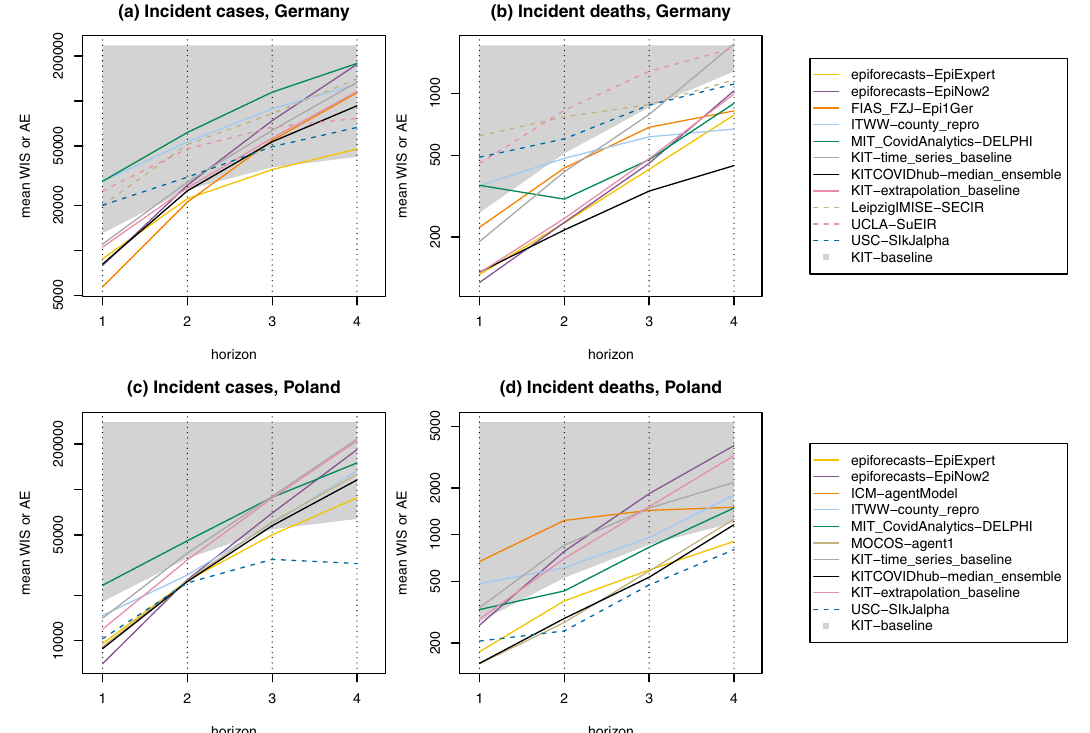
Fig. 7 Forecast performance 1 through 4 weeks ahead. Mean-weighted interval score (WIS) by target and prediction horizon in Germany ( a , b ) and Poland ( c , d ). We display submitted models and the preregistered median ensemble (logarithmic y -axis). For models providing only point forecasts, the mean absolute error (AE) is shown (dashed lines). The lower boundary of the grey area represents the baseline model KIT-baseline . Line segments within the grey area thus indicate that a model fails to outperform the baseline. The numbers underlying this fi gure can be found in Tables 1 and